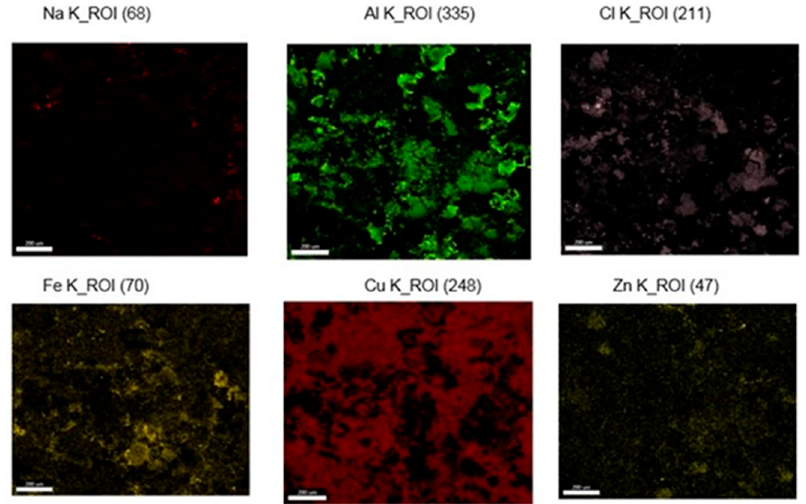
Figure 12. Elementary mapping of the EDS coating, 69 kPa C 2 H 6 –359 kPa O 2 .